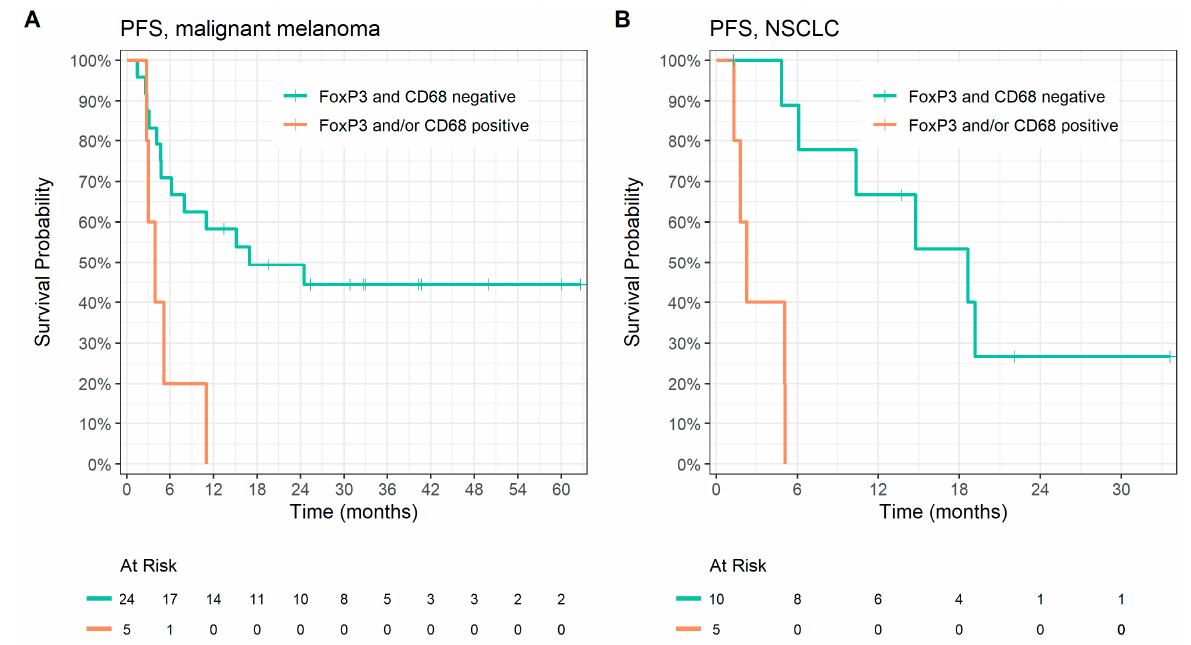
Figure 3. Kaplan–Meier analysis of progression-free survival according to FoxP3 and CD68 co-expression in ( A ) malignant melanoma, median PFS 17.0 vs. 3.9 months, p = 0.008; and ( B ) NSCLC, median PFS 19.0 vs. 2.3 months, p < 0.001.